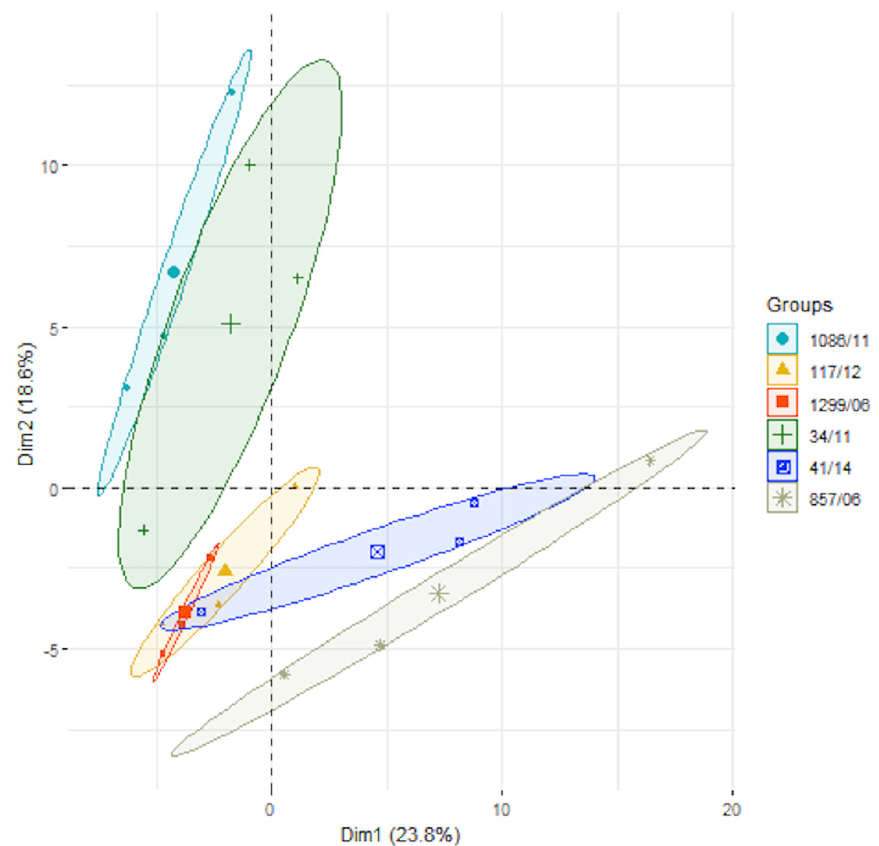
Figure 1. Principal component analysis (PCA) of the proteins identified in the six Streptococcus suis human clinical isolates.